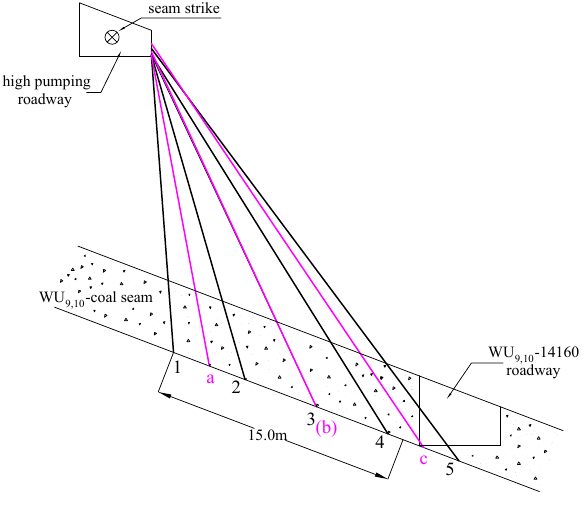
Figure 8. Cross-section of position of holes. Table 3. Drilling parameters of controlled presplitting